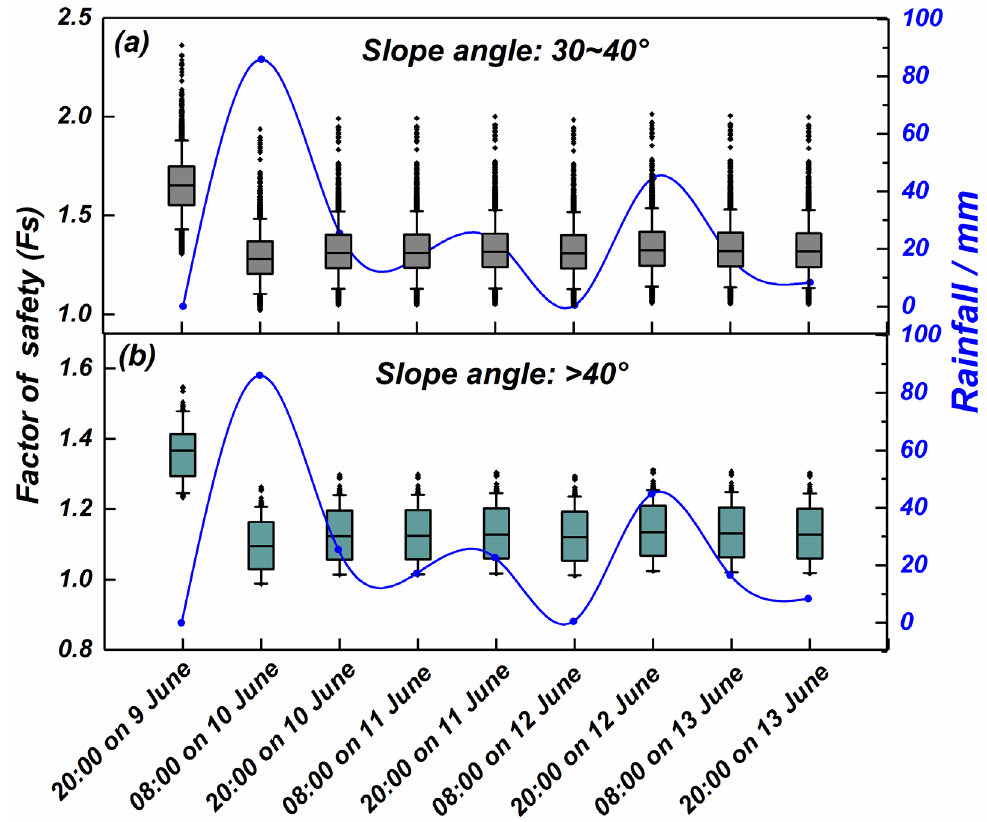
Figure 19. The statistical results of Factor of safety (Fs) in the various slope interval at different rainfall times; ( a ) slope angle: 30~40°; ( b ) slope angle: >40°.